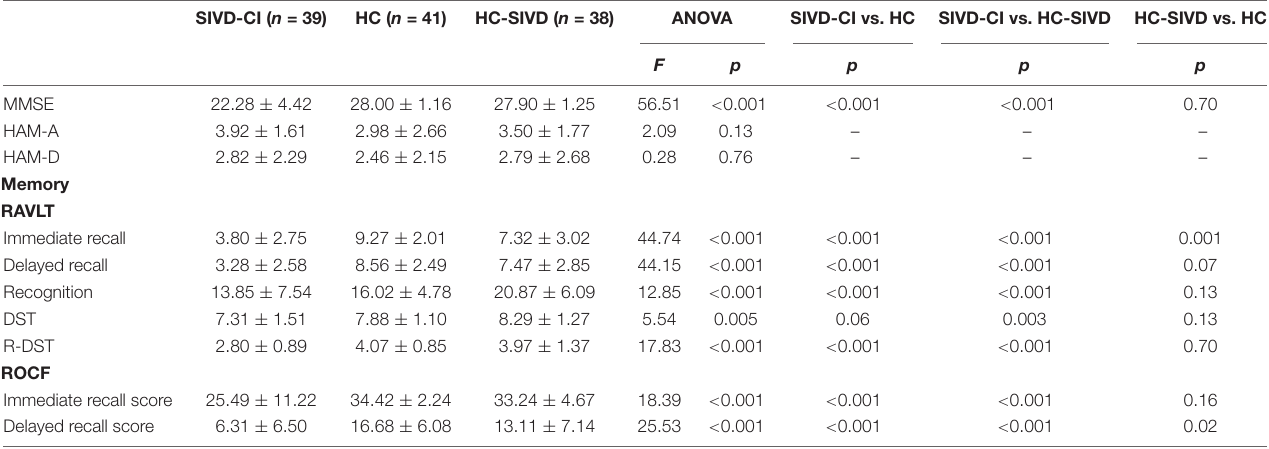
TABLE 2 | Results of Neuropsychological Tests in the SIVD-CI, HC and HC-SIVD groups. SIVD-CI ( n = 39)